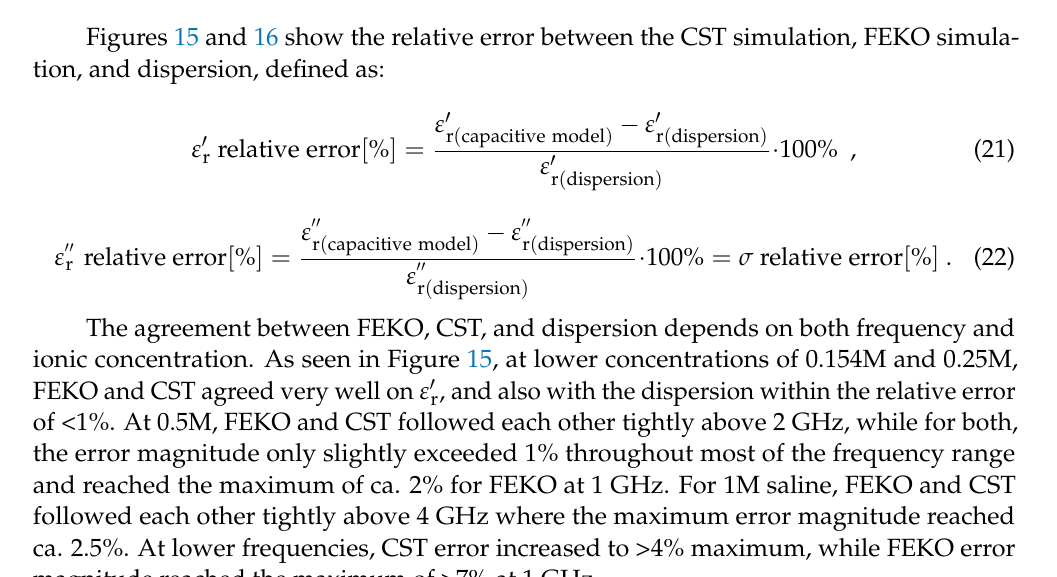
Figure 14. ε “ r for all saline solutions: simulation result obtained by postprocessing the reflection coef- ficient using the simple capacitive-load model (“capacitive model”), where the reflection coefficient was obtained by simulations either in CST (colored lines) or in FEKO (discrete points); Cole–Cole dispersion model (“dispersion”), which was the set ε “ r value for MUT in simulations (black lines) .